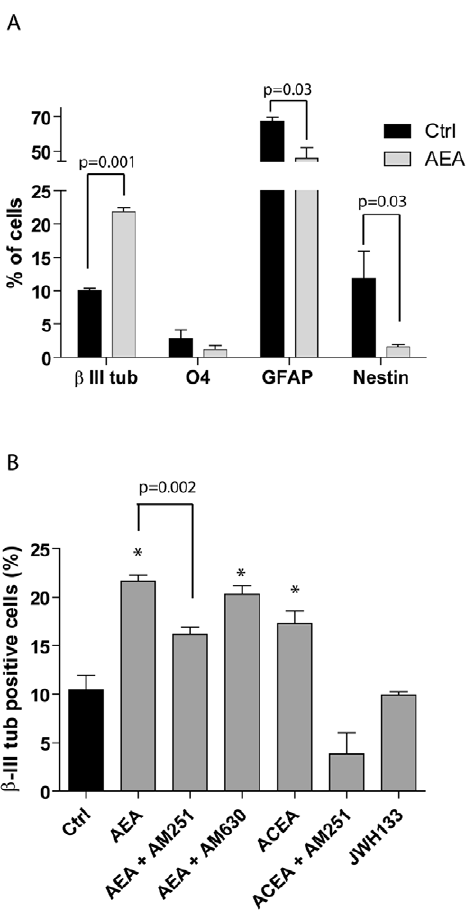
Figure 2. CB 1 receptor activation promotes neuronal differen- tiation of NSCs invitro . ( A ) The bar graph represents quantitative data (expressed in % of cells) of the immunofluorescence analysis of the effect exerted by anandamide (AEA) on NSCs cultured in differentiating condition. Immunofluorescence analysis was performed as described in Figure 1C to detect neurons ( b -III positive cells), oligodendrocytes (O4- positive cells), astrocytes (GFAP-positive cells) and progenitor cells (Nestin-positive cells) in control (black bars) and AEA-treated (grey bars) cells. Data represents the mean 6 standard deviation (SD) of 4 experiments. Statistical analysis was performed using the paired t-test; p value of statistically significant differences is reported above the bars. ( B ) The bar graph represents quantitative data (expressed in % of b -III tubulin-positive cells) of the immunofluorescence of neuronal differen- tiation of NSCs cultured in differentiating condition for 3 days in the presence or absence of AEA (1 m M), with or without the CB 1 (AM251, 1 m M) or CB 2 (AM630, 1 m M) antagonist, ACEA (1 m M) with or without the CB 1 antagonist (AM251, 1 m M), and JWH133 (1 m M). Data represent the mean 6 SD of 4 experiments. Statistical analysis of control versus treatment was performed using the paired t-test; *=p # 0.05, the p value of direct comparison of AEA + AM251 is indicated above the bars grouped by brackets. Where not indicated, samples did not show statistically significant